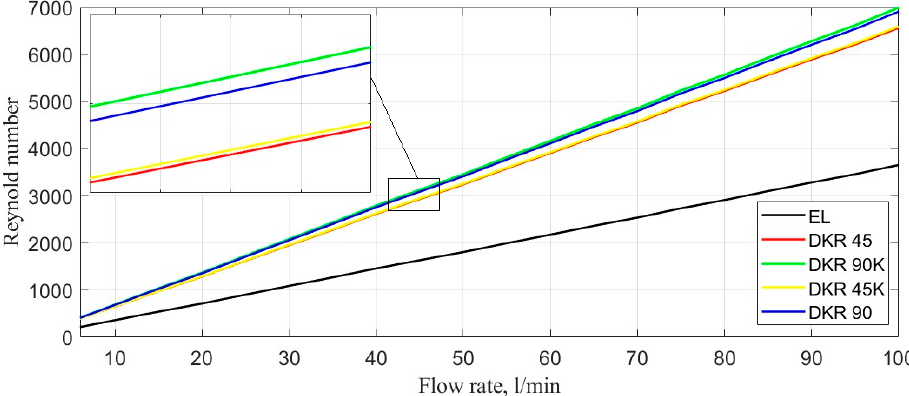
Figure 6. The Reynolds number of flow rate for angular fitting connections.